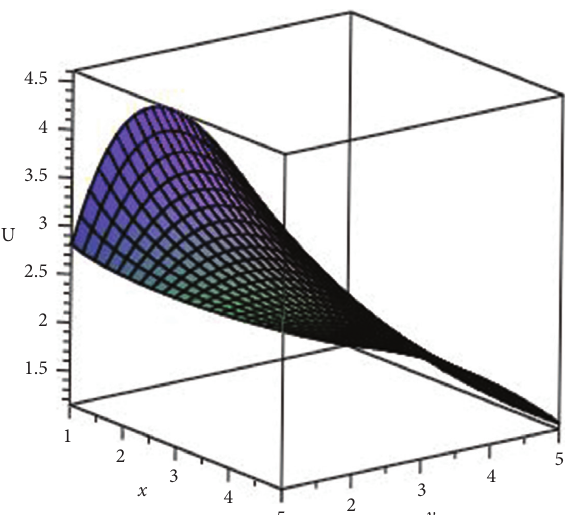
Figure 3: Graph of w given by (35) for C